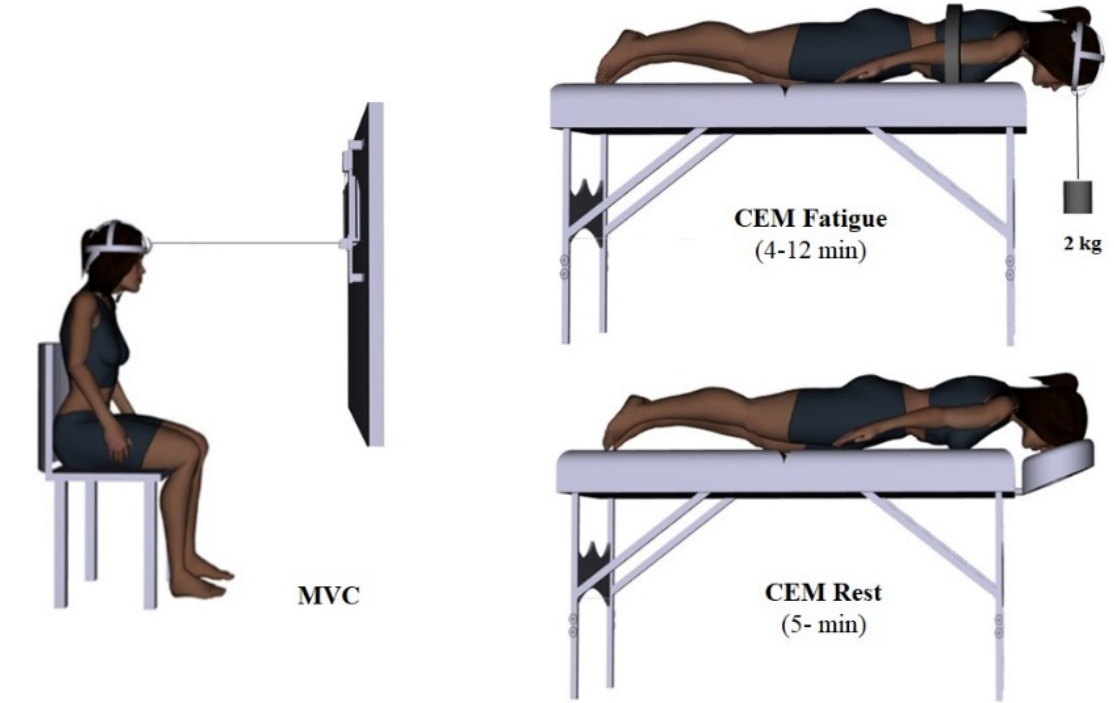
Figure 3. Left, maximum voluntary contraction set up. Isometric head/neck extension against a wall-mounted force transducer with the angle between the cable attached to the force transducer and the participant’s head remained at 90°. Each participant performed one MVC, held for 3 s. Right, submaximal CEM fatigue/rest protocol. Top, participant performing fatigue protocol. Bottom, control participant laying prone on the table for 5 min. The figures were created using Santos Pro software (SantosHuman, Inc., Coralville, IA, USA).